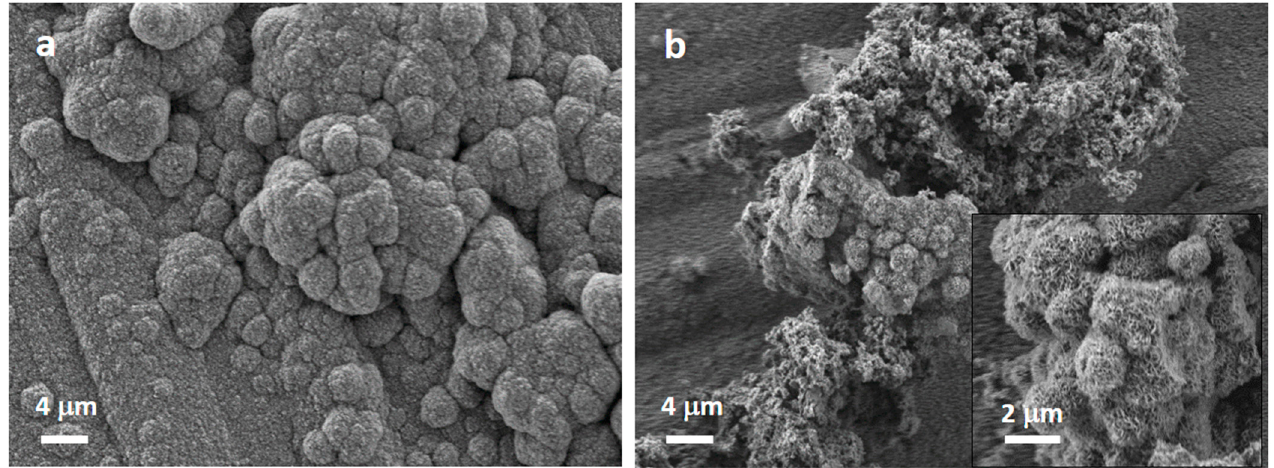
Figure 7. Scanning electron microscopy images of pellets of MBG ( a ) and MBG EOGe ( b ) after 7 days immersion in SBF.